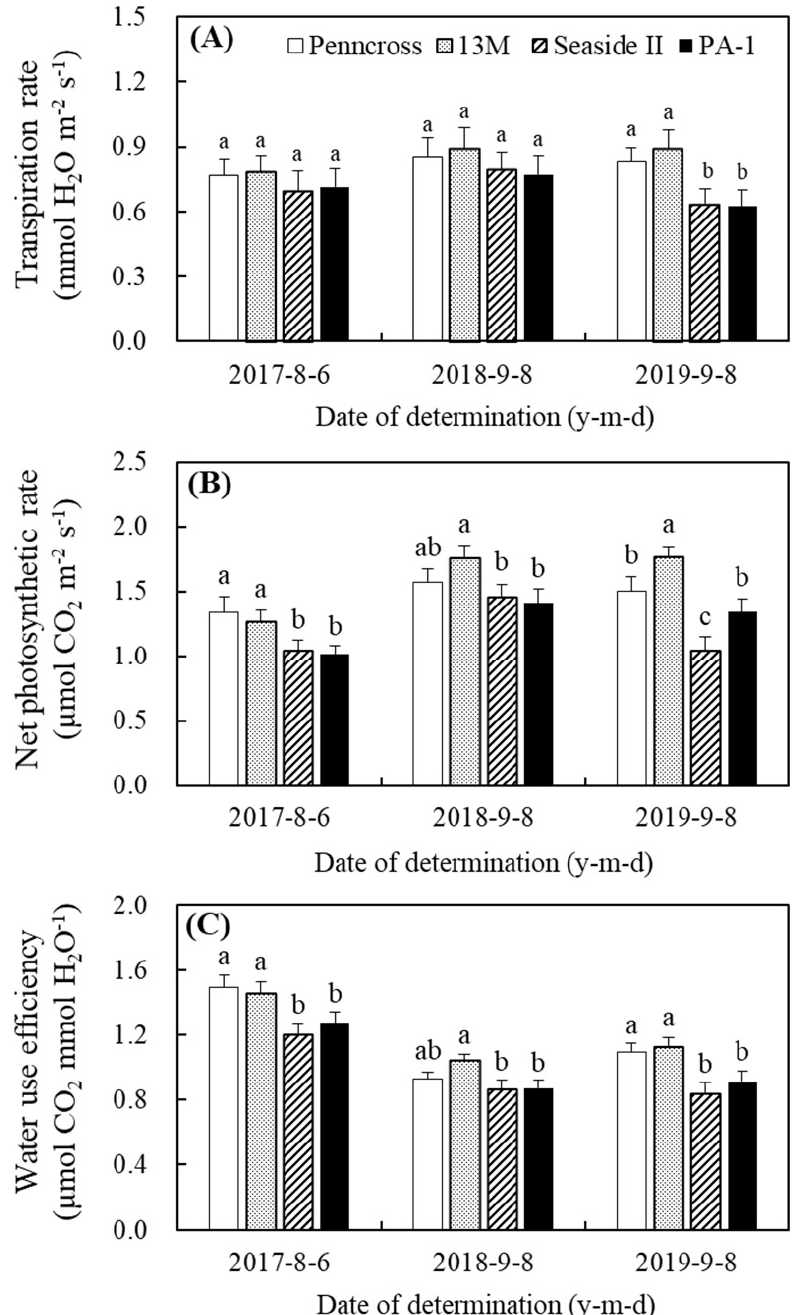
Figure 5. Change in ( A ) transpiration rate (Tr), ( B ) net photosynthetic rate (Pn), and ( C ) water use efficiency (WUE) of four different creeping bentgrass cultivars (Penncross, 13M, Seaside II, and PA-1) during summer in ( A ) 2017, ( B ) 2018, and ( C ) 2019. Vertical bars indicate ± SE of mean (n = 4). Different letters indicate significant differences ( p < 0.05) at a given day.